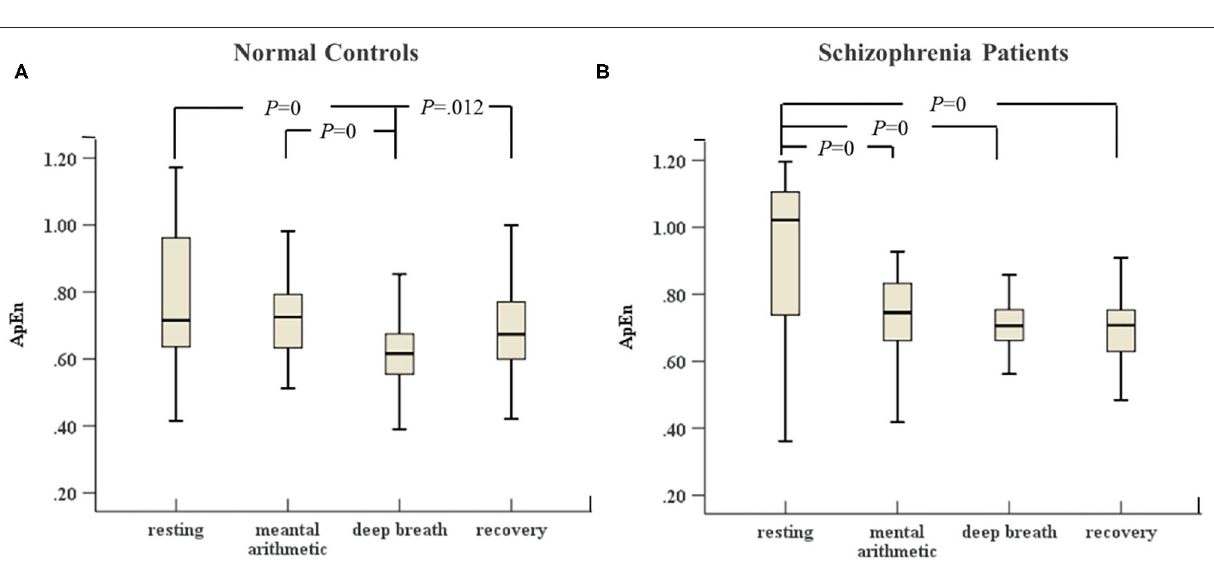
tone, were significantly lower than those of normal controls.